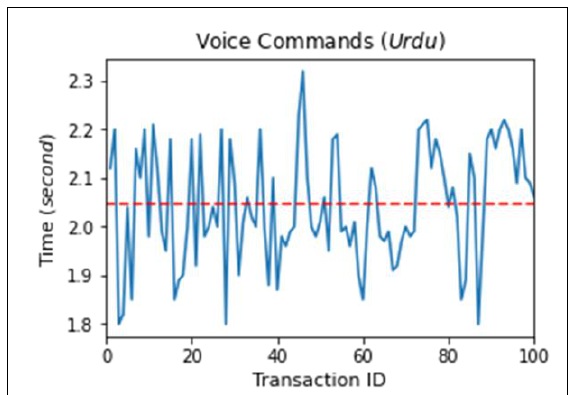
Figure 5. Total Response Time